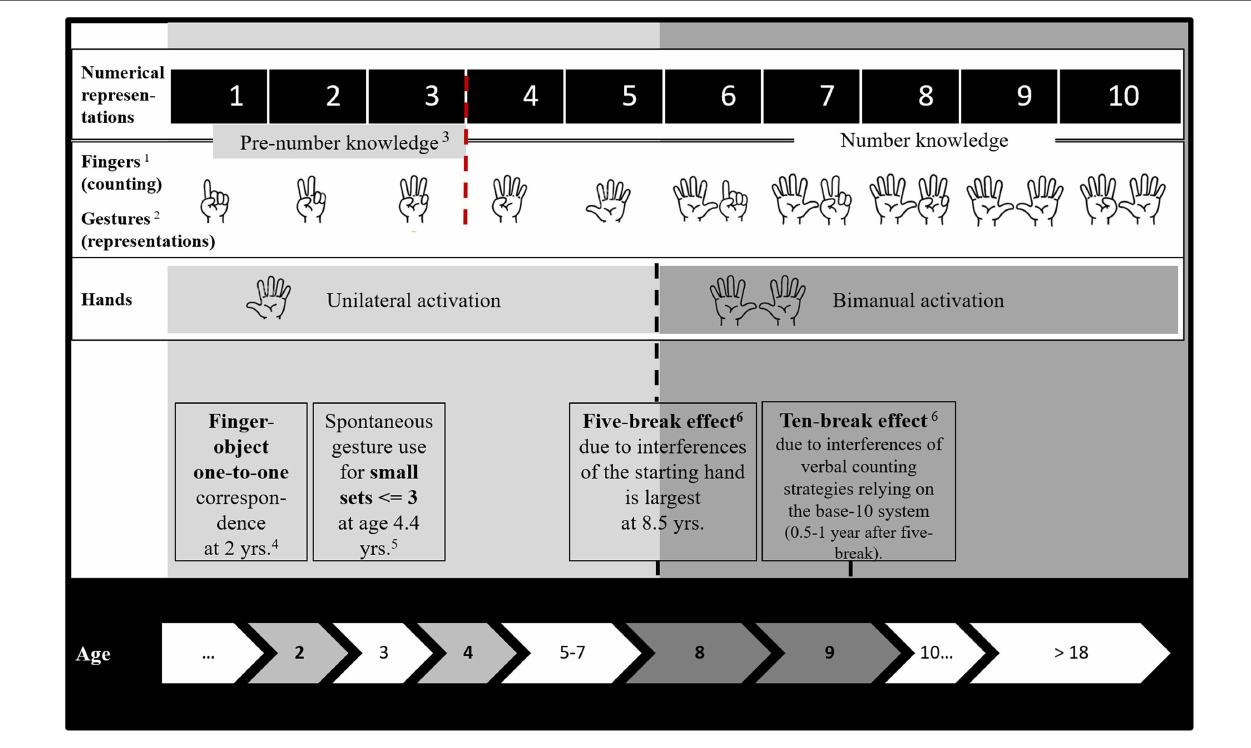
FIGURE 1 | The development of finger/hand-based numerical representations that are relevant for numerical choices. The empirical evidence summarized here stems from the following references: 1 Starting finger/hand for counting: Fischer et al., 2008; Lindemann et al., 2011; 2 Starting finger for gesturing: Wasner et al., 2015; Spontaneous gestures: Noël, 2005; Di Luca and Pesenti, 2008; Goldin-Meadow et al., 2014; 3 Number sense in infancy predicts mathematical performance at 3.5 years: Starr et al., 2013; 4 Pointing gestures: Gelman and Gallistel, 1986; 5 Accurate gesturing for sets of three and fewer: Gunderson et al., 2015; and 6 The five- break and 10-break effects at specific ages: Domahs et al.,